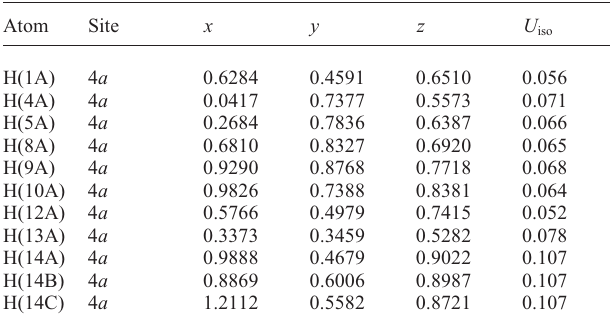
Table 2. Atomic coordinates and displacement parameters (in Å 2 )